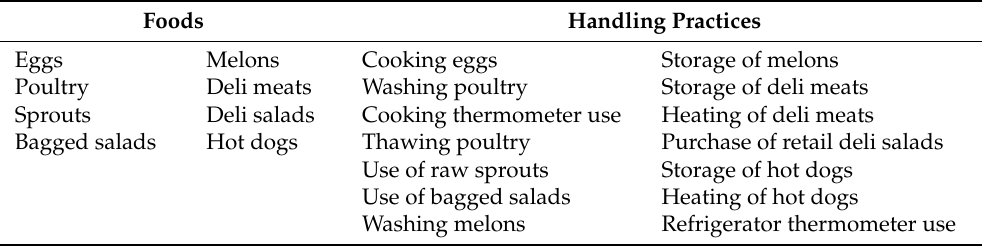
Table 1. Common foods that could be contaminated with Salmonella , Campylobacter or Listeria, and related food-handling practices included in the focus group questioning route. Foods Handling Practices Eggs Melons Cooking eggs Storage of